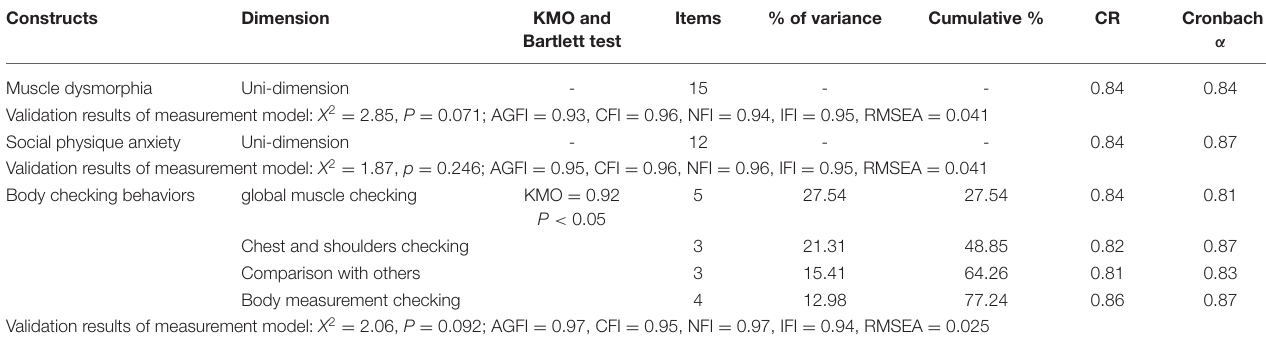
TABLE 1 | The statistics table of quality analysis of three measuring scales. Constructs Dimension KMO and